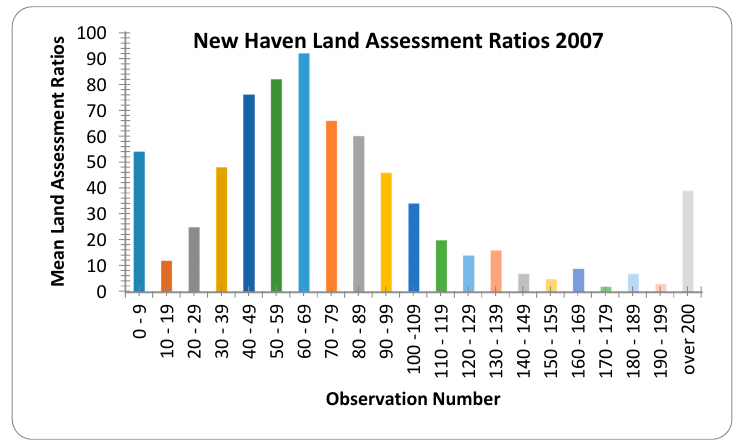
Figure 6. Land assessment ratios in New Haven for the tax year 2007. The observation number (horizontal axis) is a range, and the Mean Land Assessment Ratio (vertical axis) is the mean overall ratio in the corresponding range. For instance, 0–9 indicates observations 0 to 9; …; over 200 indicates observations 200 and over. Table 3. Land ratio descriptive statistics for all qualified sales in New Haven.